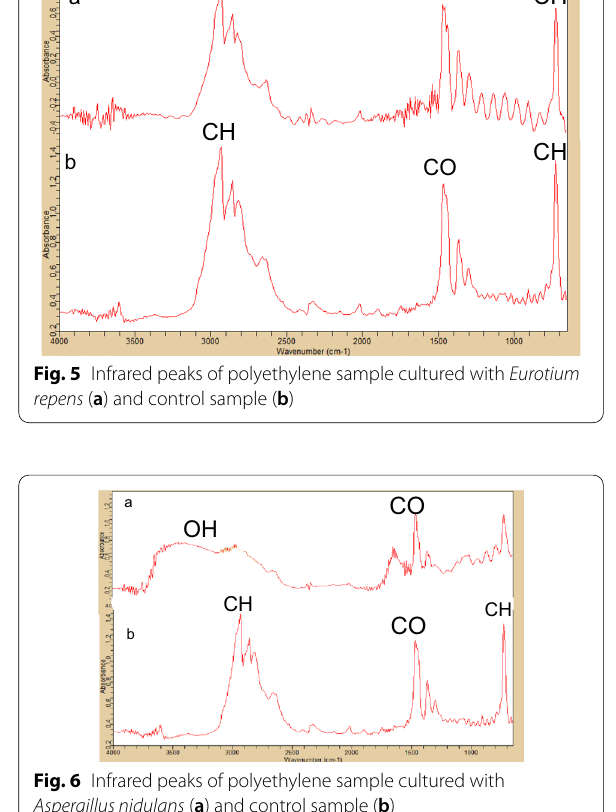
Fig. 4 Infrared peaks of polyethylene sample cultured with Penicillium chrysogenum ( a ) and control sample ( b )